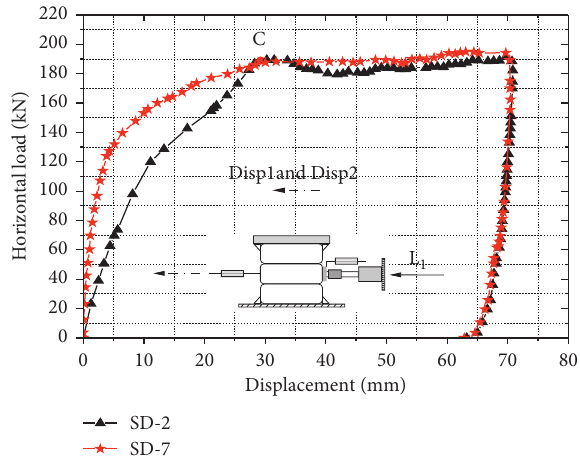
Figure 18: Load-displacement curve of specimen with different density.